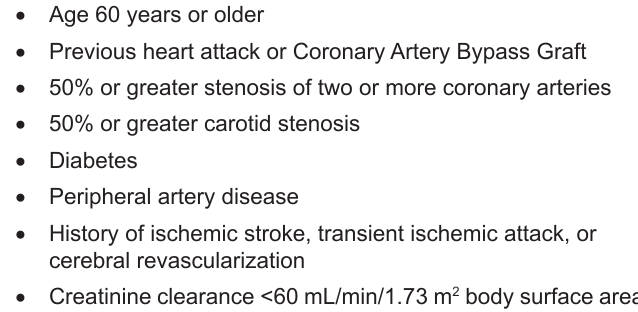
Table 2. Risk factors for inclusion in platelet inhibition and patient